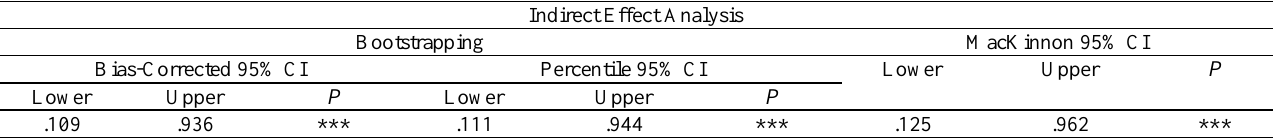
Table 5: Bootstrapping and MacKinnon 95%